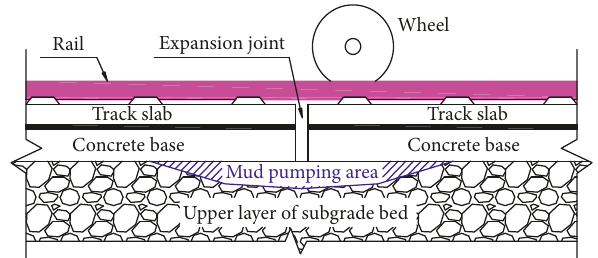
Figure 15: The longitudinal profile of the ballastless track-subgrade with mud